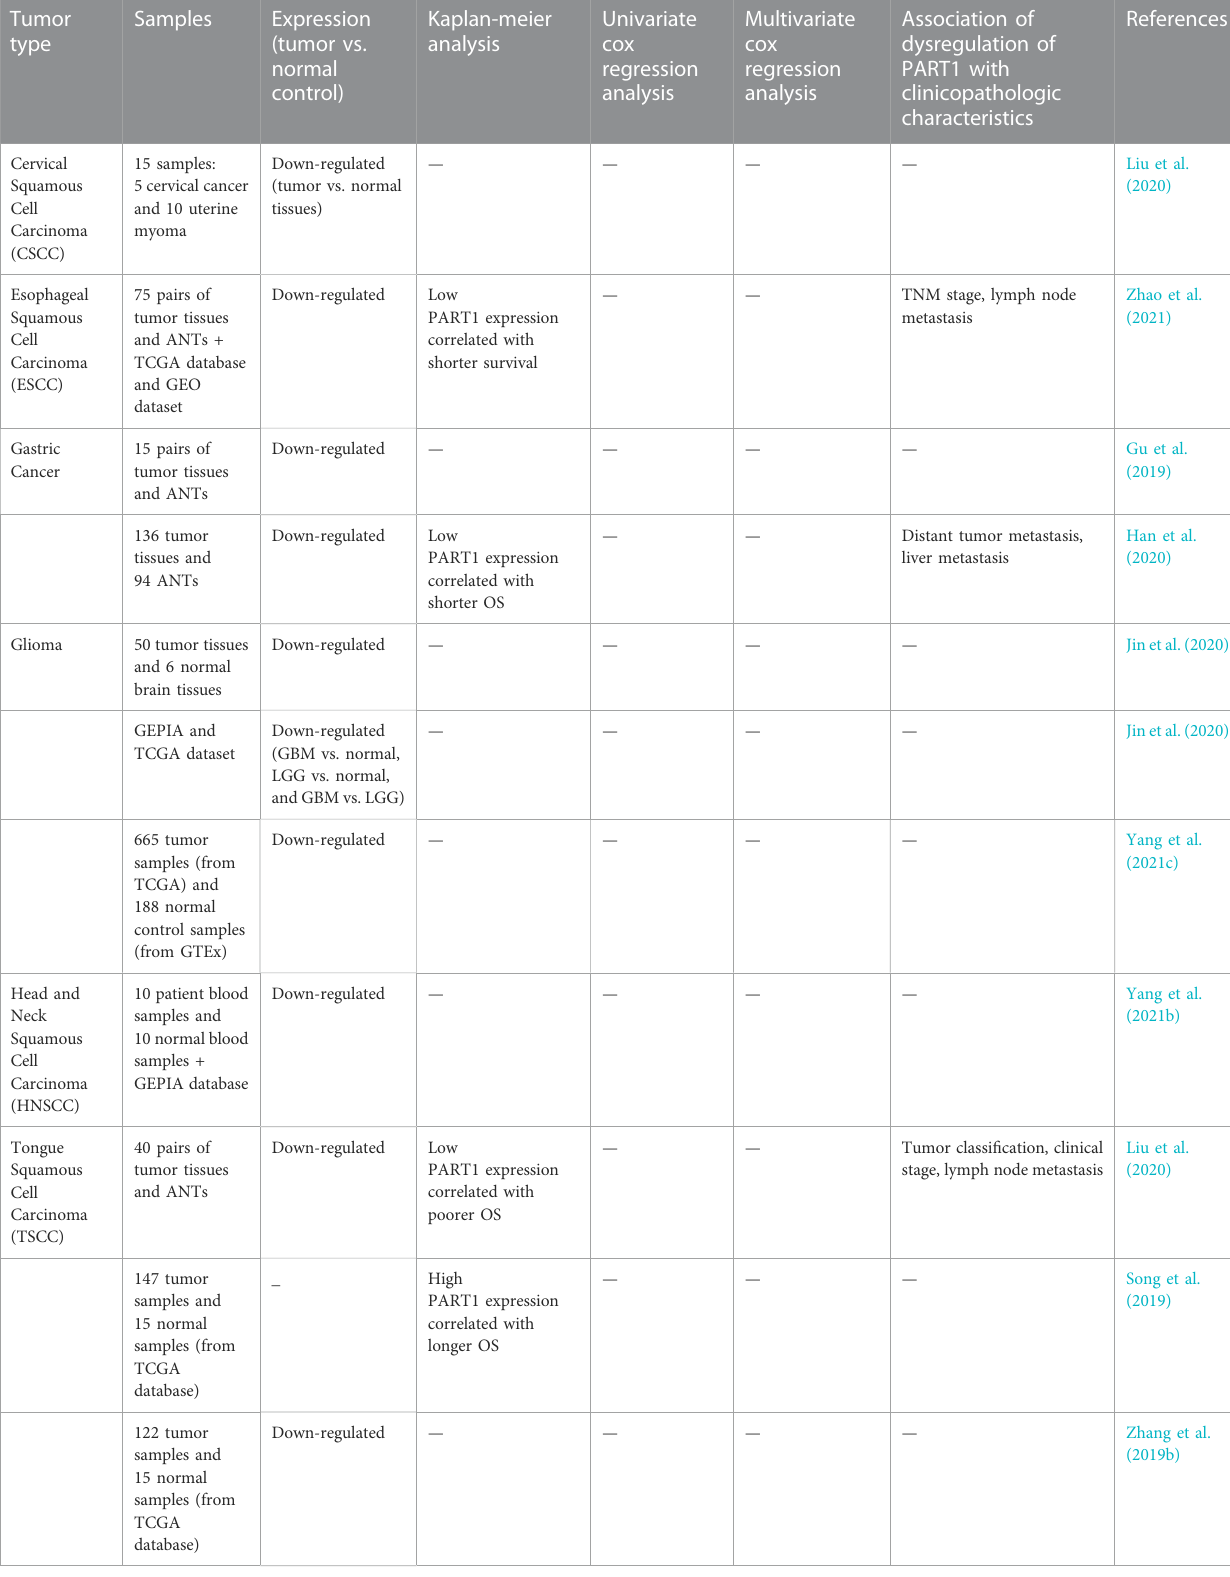
TABLE 5 Function of PART1 down-regulation in the development of malignancy on the basis of studies in clinical samples. Tumor